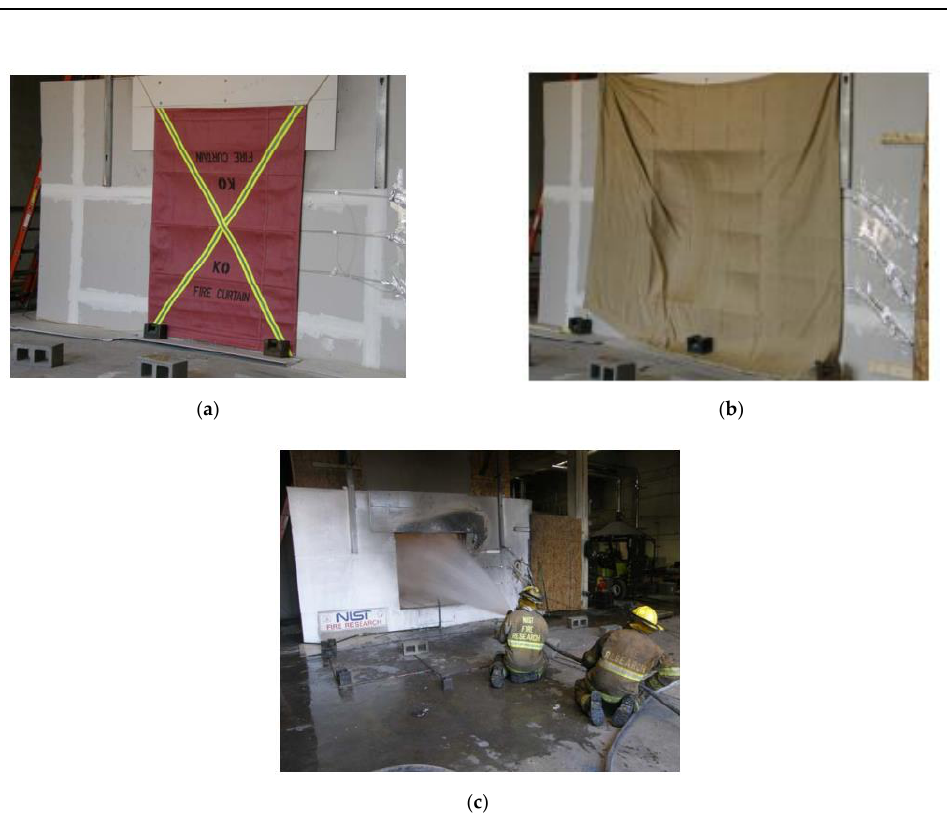
Figure 10. Installation of wind-control devices (WCD). ( a ) Small WCD located in window, ( b ) Large WCD located in window, ( c ) Water spray into window.